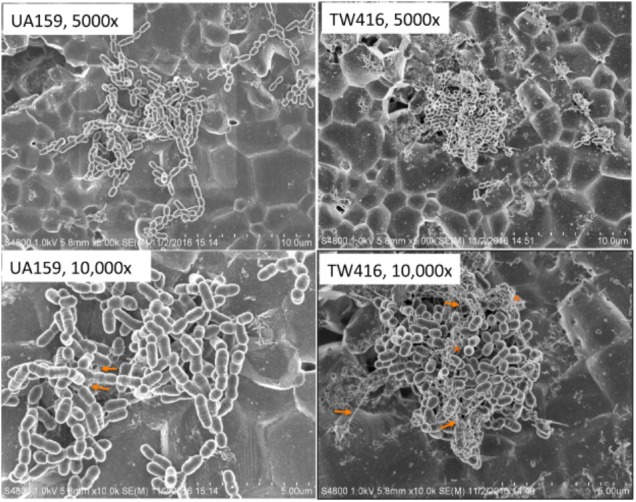
SEM analysis of biofilms. S. mutans wildtype (UA159), the mecA mutant (TW416) and its complement strain (TW416C) were grown in BM medium with glucose and sucrose, glucose or sucrose. Biofilms were grown on HA disks vertically placed in 12 well plates for 24 h, and analyzed using a scanning electron microscope (SEM). Panel shows images of UA159 and TW416 biofilms grown in BM plus glucose and sucrose, which were taken at magnification of 5,000 and 10,000 × g as indicated, with arrows indicating extracellular polymeric substances and asterisks indicating broken cells and cell debris, respectively.